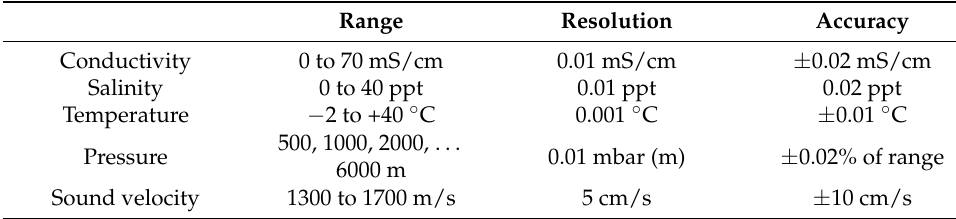
Table 4. Specifications for STD/CTD model SD204.